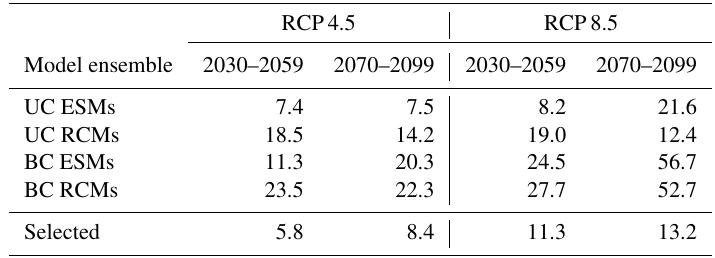
Figure 12. Monthly discharge changes of uncorrected (UC) and bias-corrected (BC) Earth system model (ESM) and regional climate model (RCM) simulations in % under RCP8.5 (2070–2099). Monthly changes are relative to average annual discharge in the reference period (1970–1999) at gauge El Diem. Table 2. Projected changes in average annual discharges relative to 1970–1999 in